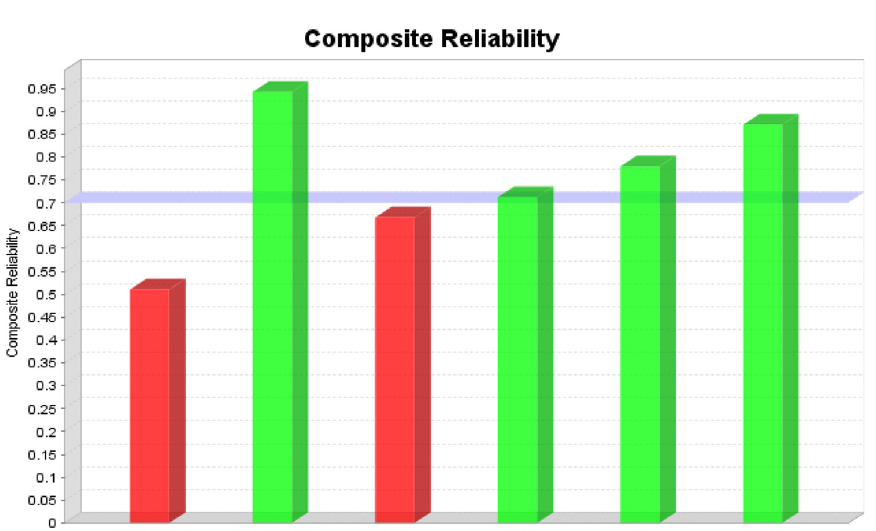
Figure 5. Cronbach ’ s alpha for internet banking non-